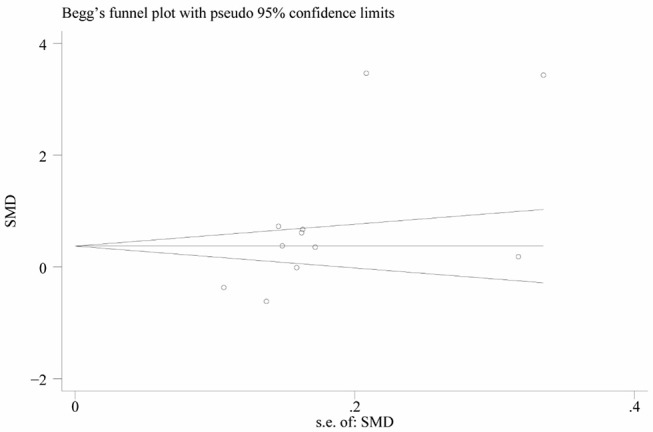
Funnel plot of standard mean difference (SMD) in serum uric acid level between the BPPV and control groups.